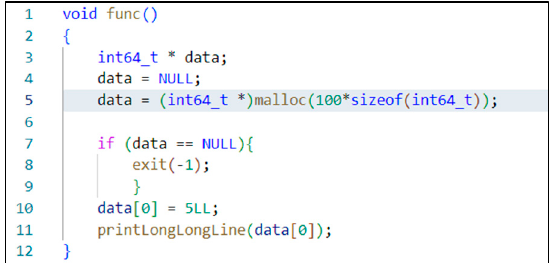
Figure 2. Code snippet from Samate Juliet Test Suite.